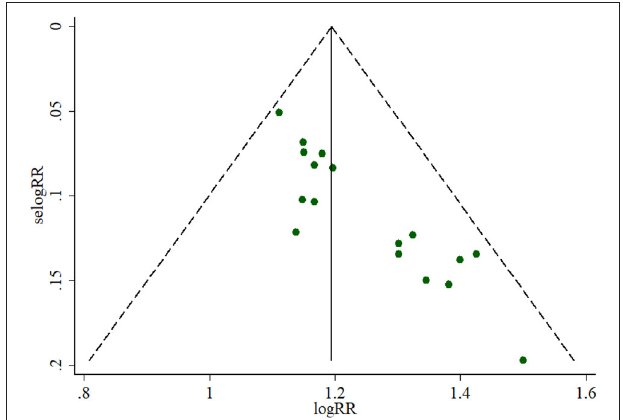
FIGURE 3 | Funnel plot of outcome measure symptoms.